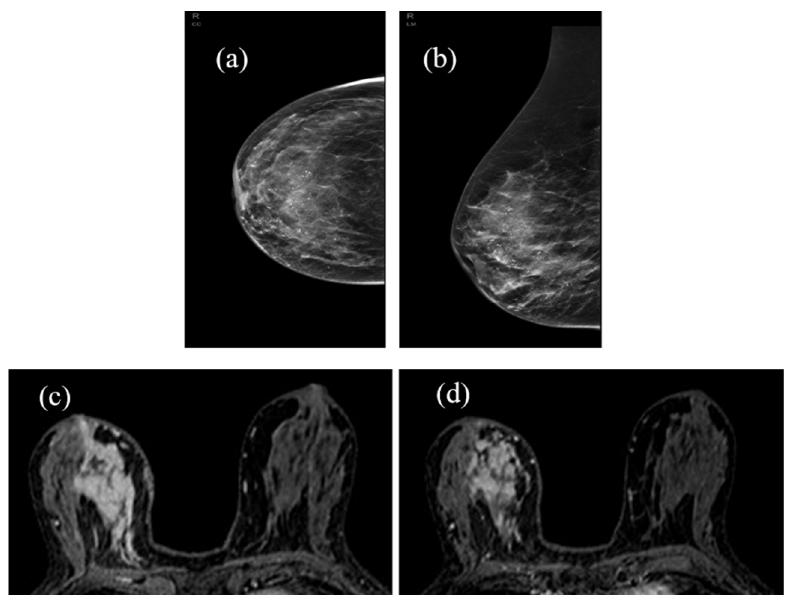
Figure 7. Stable disease (SD): Mammography shows the presence of a large area of granular microcalcifications in the right lower inner quadrant, unchanged during NAC ( a , b ). In MRI, it is evident in the same large area of pathological enhancement ( c ) that does not show significant changes in the extent and activity at the end of therapy. The BPE also appears unchanged ( d ). Histological type: invasive and in situ non-special type carcinoma (ductal).